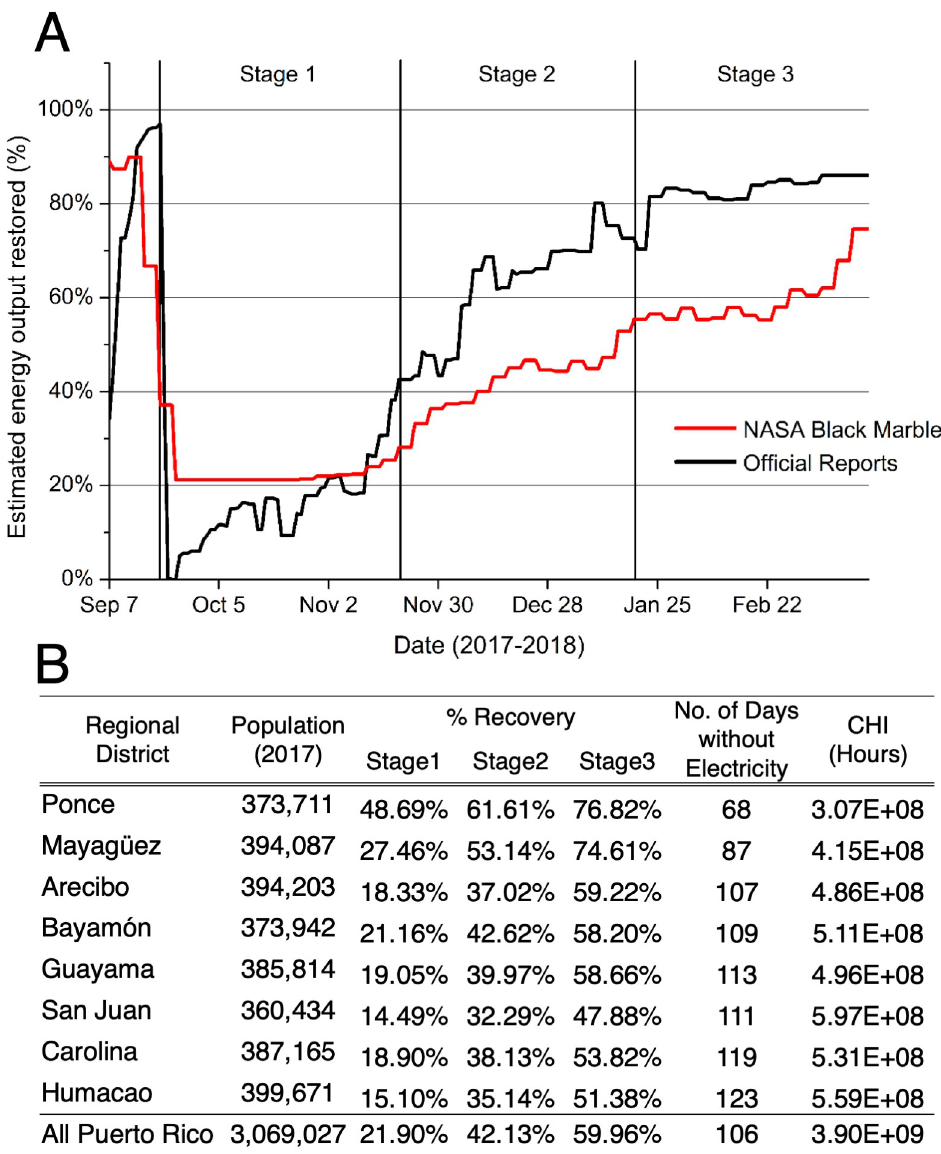
PLOS ONE | https://doi.org/10.1371/journal.pone.0218883 June 28,